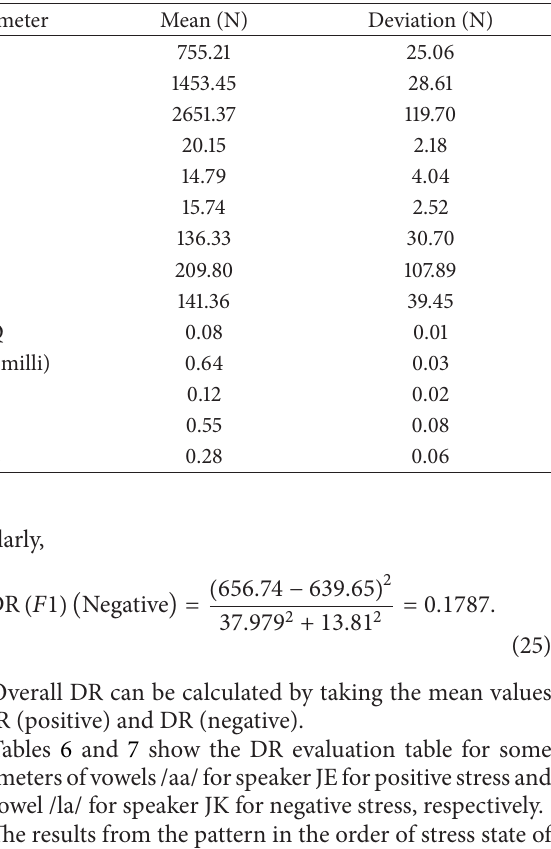
Table 7: DR evaluation table for vowel /la/ for speaker JK.